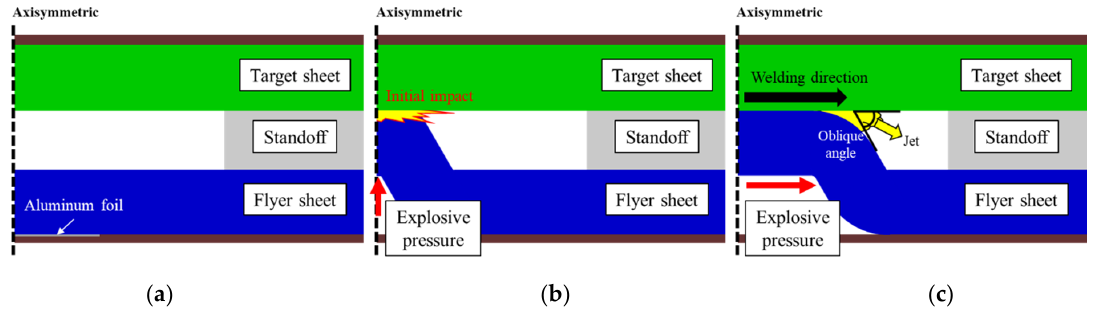
Figure 1. Welding mechanism of VFAW process: ( a ) initial set-up; ( b ) initial impact due to Al foil vaporization; ( c ) explosive pressure distribution.